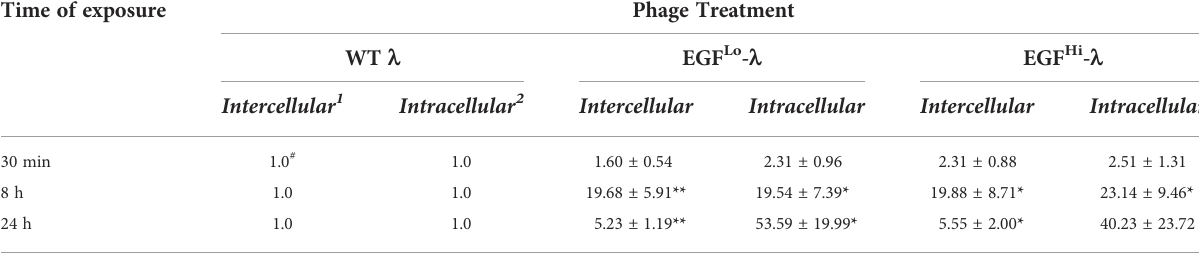
TABLE 1 EGF targeting of l phage enhances uptake into HT-29 colorectal cancer spheroids and facilitates cellular entry. Time of exposure